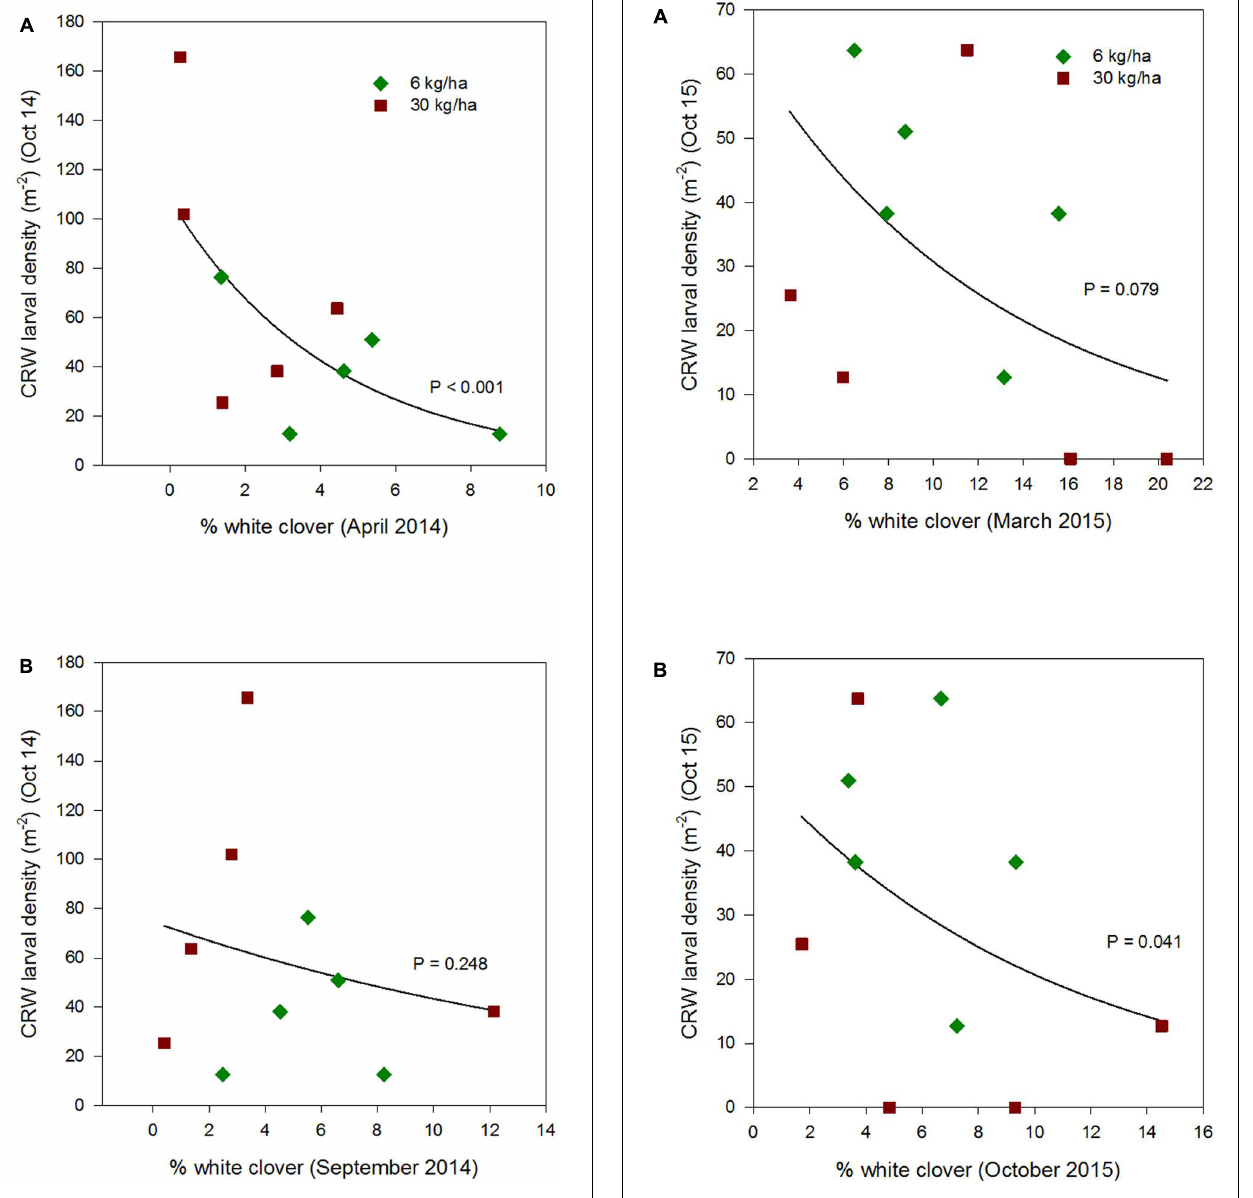
FIGURE 5 | Clover root weevil larval densities measured in October 2014 in relation to % white clover measured in April 2014 (A) and September 2014 (B), from ryegrass plots (cv. Nui) sown at 6 and 30 kg/ha (solid line shows the estimated relationship across all plots, irrespective of ryegrass sowing rate).